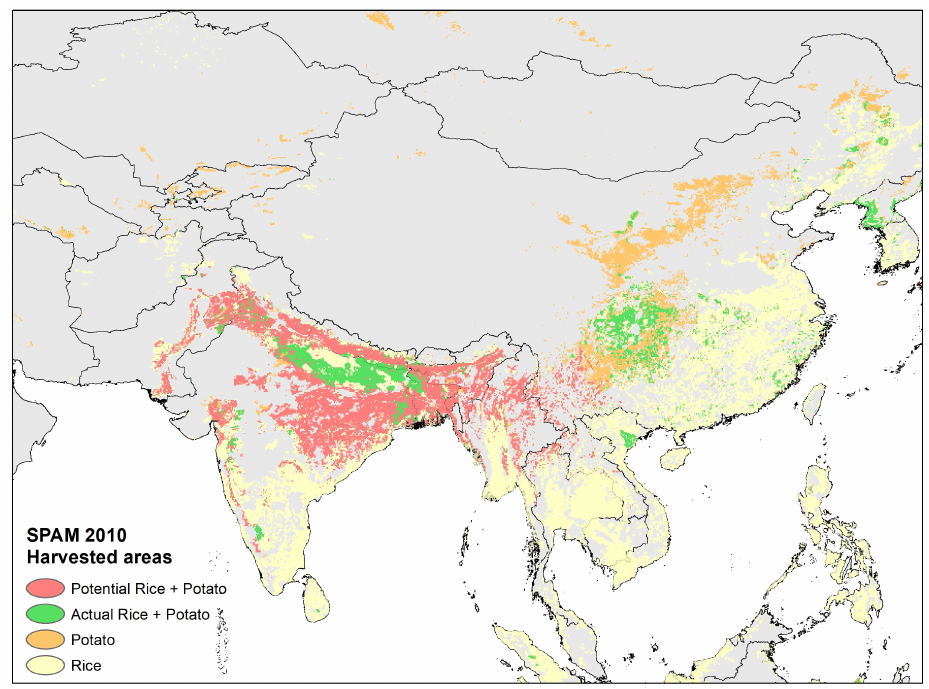
Figure 2. Potato- and rice-harvested areas estimated from SPAM 2010 [31] for Asian